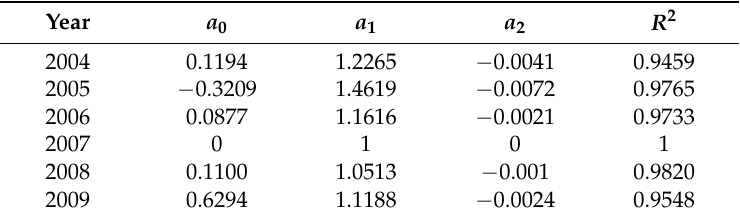
Table 2. Coefficients adopted for calibration of NTL series of